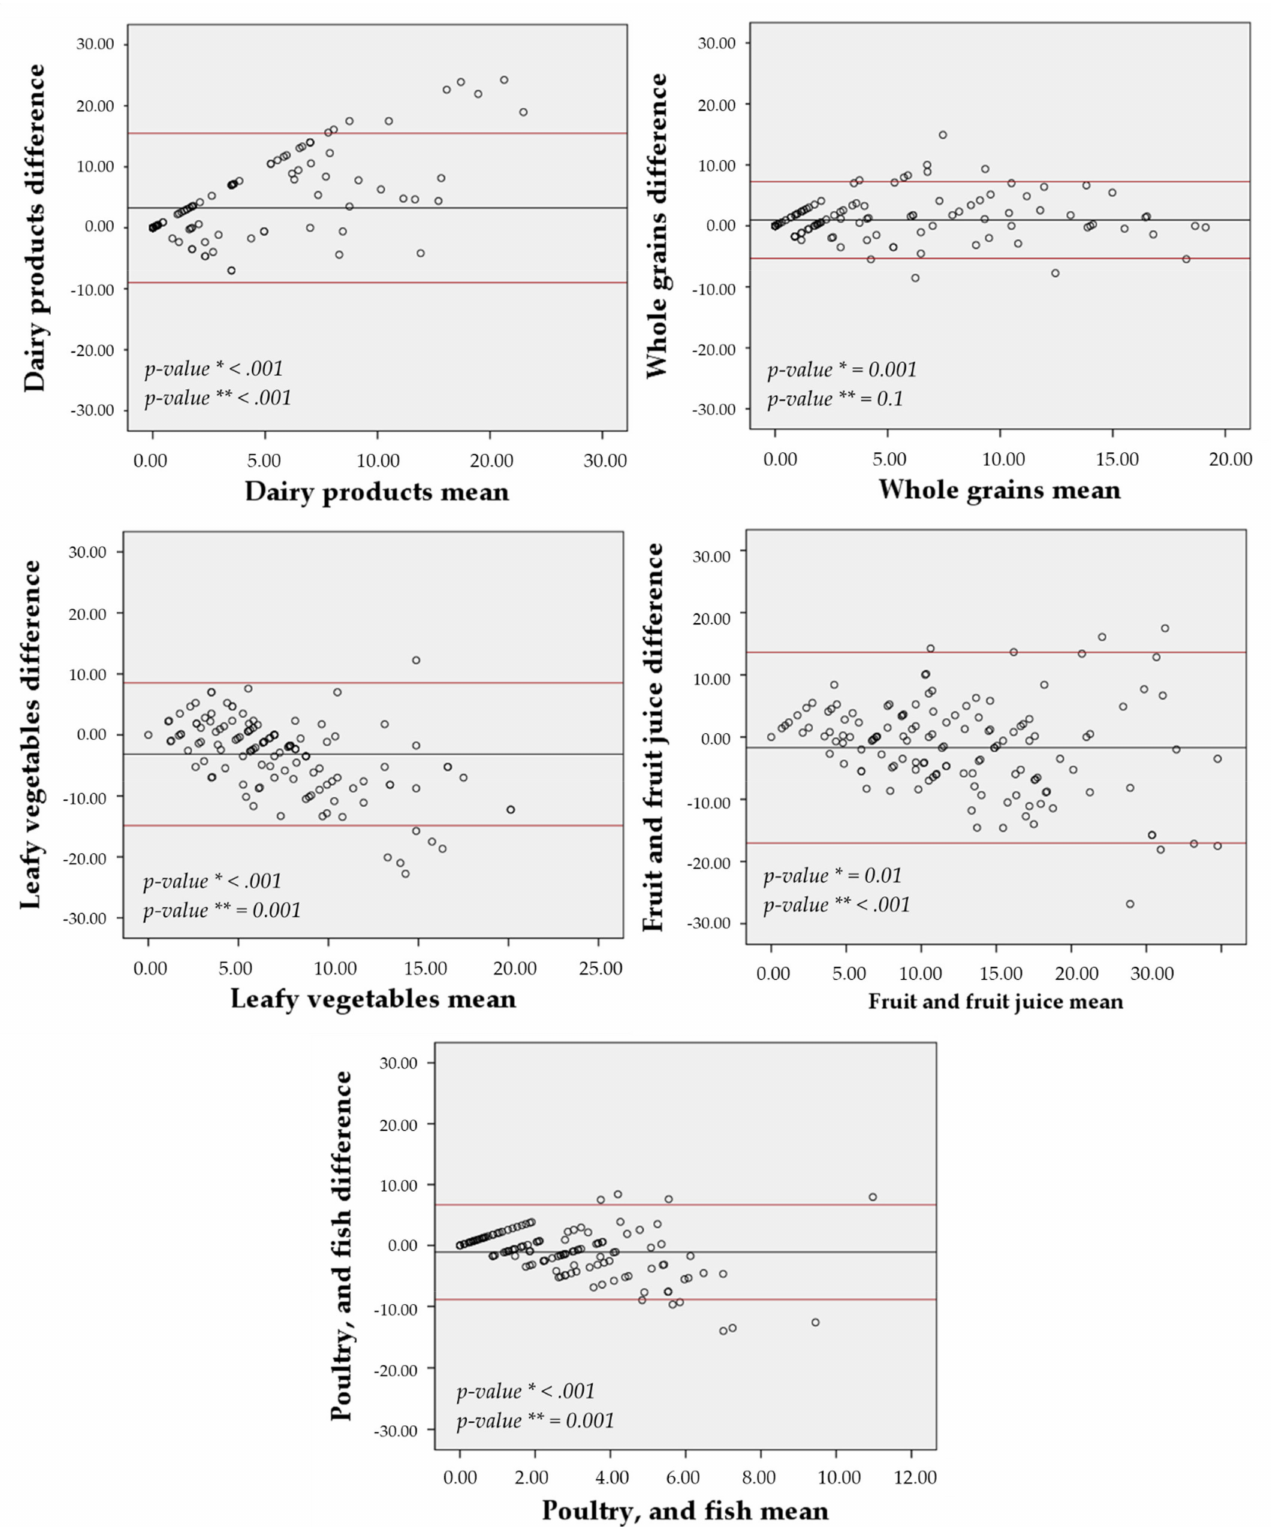
Figure 5. Bland-Altman agreement between the 7-day FG-QFFQ with the 24-h dietary recalls. * p -value for non-zero difference between methods ( t -student test) and ** p -value for propensity bias (regression